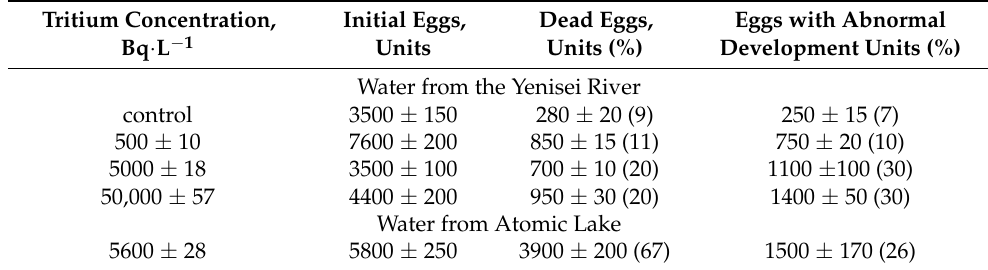
Table 3. Effects of the tritium water on the development of carp eggs 25 days after starting the experiment ( p =